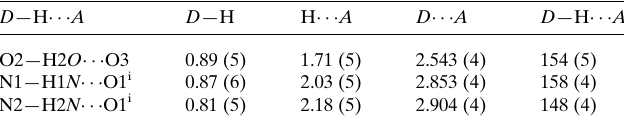
Table 1 Hydrogen-bond geometry (A˚ , (cid:2) ).